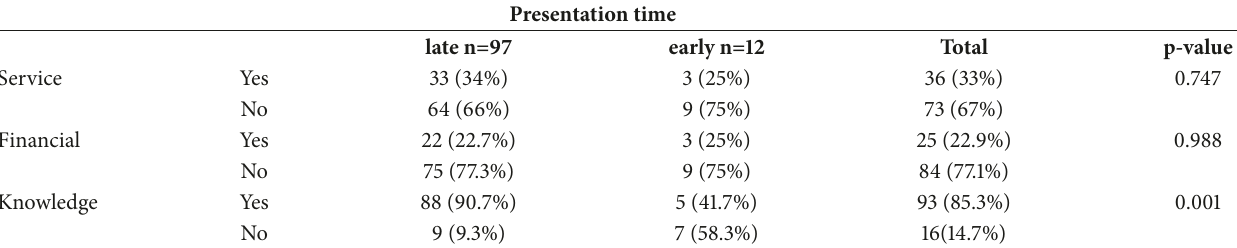
Table 5: Barriers to early care